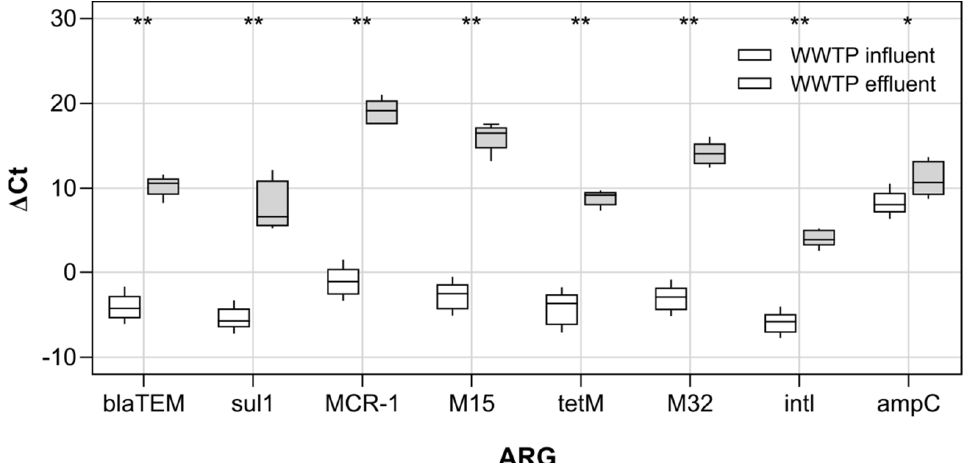
Figure 3. Relative abundance obtained from qPCR Ct values (normalized ARGs copies to 16s rRNA copies) of the seven ARGs analyzed in bacteria from the influent and effluent of Brno-Mod ř ice WWTP. Box plots represent the median (horizontal line in the box), the lower and upper quartiles (bottom and top box lines), and the lower and upper 1.5 IQR (bottom and top whiskers). The statistical difference between the influent and effluent was tested by Mann-Whitney test and the significance is marked with * for p < .05, ** for p < .01